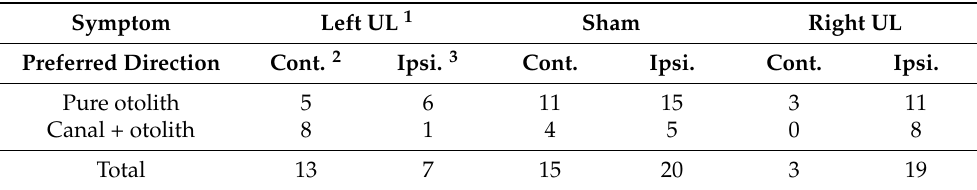
Table 2. The number of contra- and ipsi-preferred neurons in each